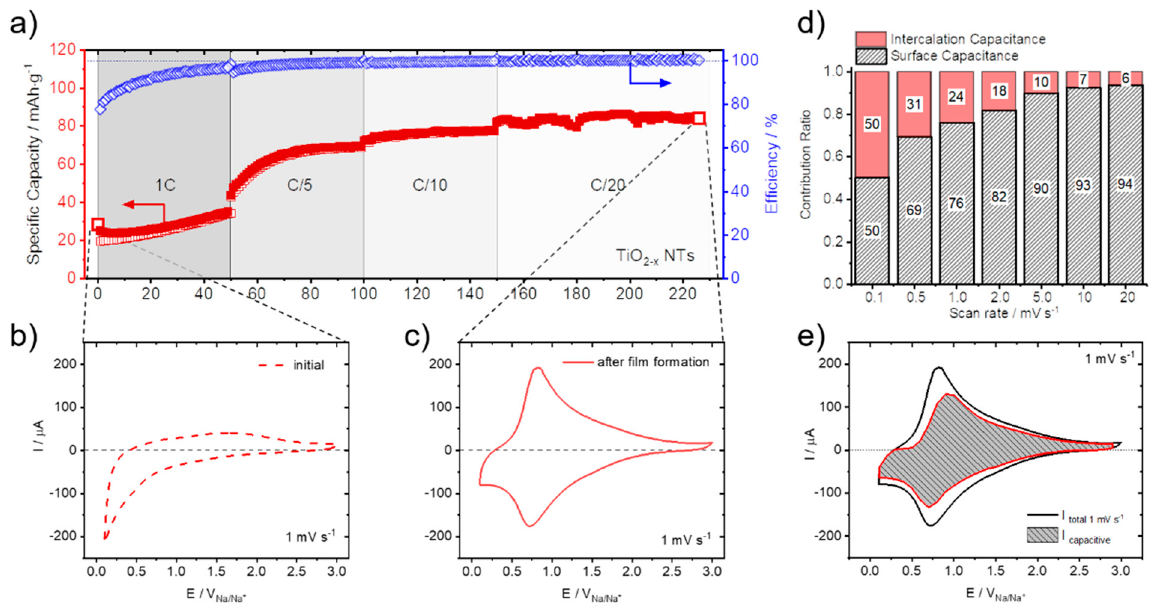
Figure 1. Self-Improving Na-ion storage: ( a ) Specific gravimetric capacities and Coulombic efficiencies versus sodiation/desodiation cycle number of TiO 2 − x NTs, measured at different C-rates (from 1C to C/20) between 3.0 V and 0.1 V (sodiation: filled squares / desodiation empty squares). ( b ) CV measured before and ( c ) after film formation at a scan rate of 1 mV s − 1 . ( d ) Contribution ratio of capacitive and insertion charge versus scan rate. ( e ) Separation of capacitive (gray shaded area) and total (black line) current at a scan rate of 1 mV s − 1 . Measurements were performed in the Na-containing electrolyte (see Section 2). Reproduced and modified in part with permission from reference [21].